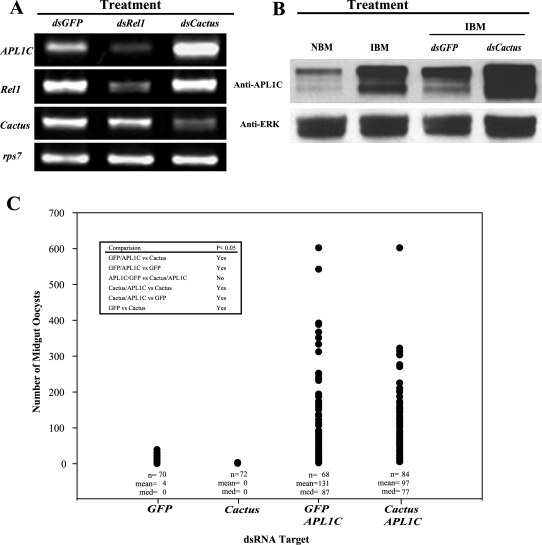
A. APL1C mRNA is regulated by the Rel1/Cactus immune signaling pathway. Semi-quantitative RT-PCR was used to measure the effect of Rel1 and Cactus knockdown on APL1C transcript abundance. Labels above gel indicate the dsRNA that was used for the knockdown, labels to the left indicate the transcript whose abundance was measured. APL1C level was decreased by Rel1 silencing, and increased by Cactus silencing, consistent with a model whereby APL1C RNA is regulated positively by Rel1 and negatively by Cactus. Specificity is shown by dsRel1 and dsCactus silencing of cognate RNA levels. B. APL1C protein abundance is regulated by P. berghei infection and Cactus. Western blot analysis of APL1C protein abundance 24 h after P. berghei infection in naïve, dsCactus knockdown, and dsGFP control mosquitoes. Total protein abundance of ERK detected by anti-ERK antibodies was used as a protein loading control. C. APL1C is required for Rel1-mediated host-defense against P. berghei. The functional effect of Cactus and APL1C activity on the outcome of P. berghei infection was tested using gene knockdowns. The RNAi knockdown target is shown on the horizontal axis. GFP was used as a control dsRNA. The vertical axis shows the number of midgut oocysts 7–8 d following a P. berghei IBM. Sample sizes (n), means (mean), and medians (med) are given for knockdowns, which were each pooled data from 2 independent experiments. The oocyst loads differed significantly (p<0.001) among samples by Kruskal Wallis one way ANOVA on Ranks. Pairwise comparisons using Dunn's method of multiple comparisons are given in the inset box. dsCactus-treated mosquitoes were completely protected from infection, with no successful oocyst development. In distinction, the double knockdown of APL1C simultaneously with Cactus produced mosquitoes with ∼25-fold more oocysts than the dsGFP-treated controls, a result that was no different than the dsAPL1C-treated mosquitoes. Thus, in the absence of APL1C, Rel1 activation has no effect on parasite development, indicating the requirement of the presence of APL1C for Rel1-mediated host defense against P. berghei. Note that dsGFP was included in the APL1C knockdown so that total amount of input dsRNA per mosquito was the same as in the Cactus-APL1C double knockdown, eliminating dsRNA concentration as a variable.